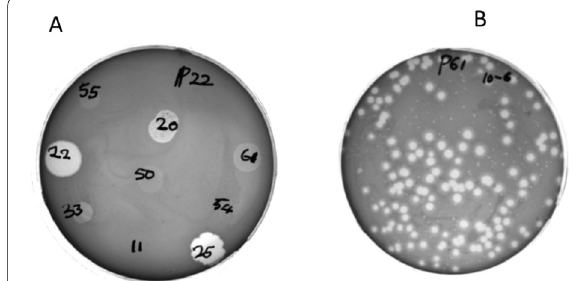
CLSI Clinical Laboratory Standard Institute